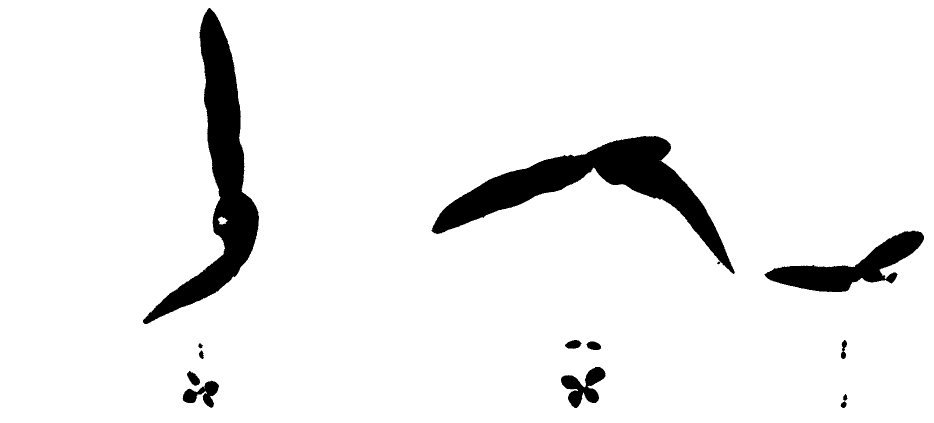
Figure B1. Index of images scaled equally.